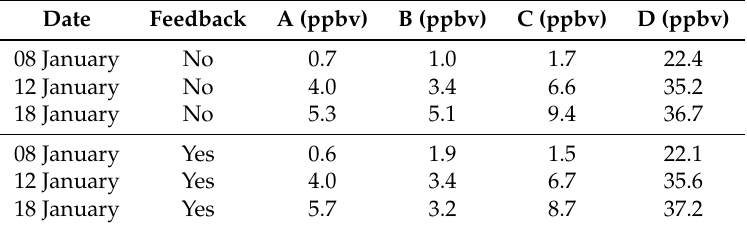
Table 5. Table showing differences in average ozone (ppbv) between 6:00 a.m. and 5:00 p.m. for